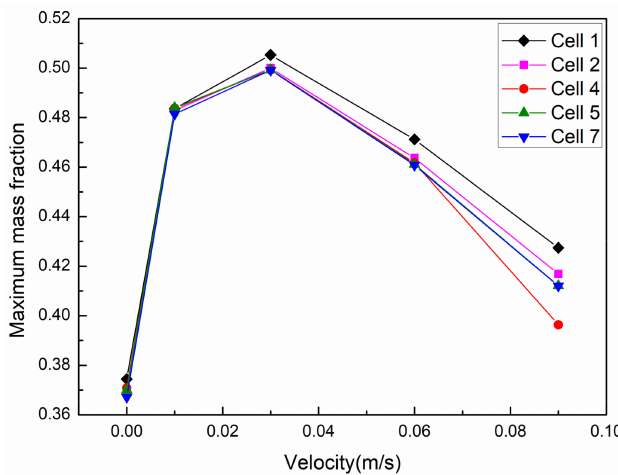
Figure 5. Change of maximum rhodamine mass fraction on cell surfaces with the relative velocity of microdroplet to culture solution when culture solution velocity is 0.01 m/s.